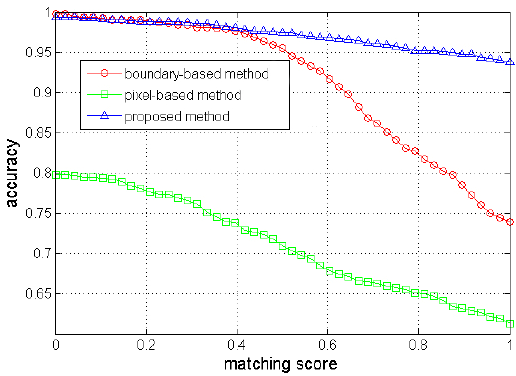
Figure 6. Segmentation accuracy with different methods on the pedestrian lane detection and vanishing point estimation (PLVP) dataset.